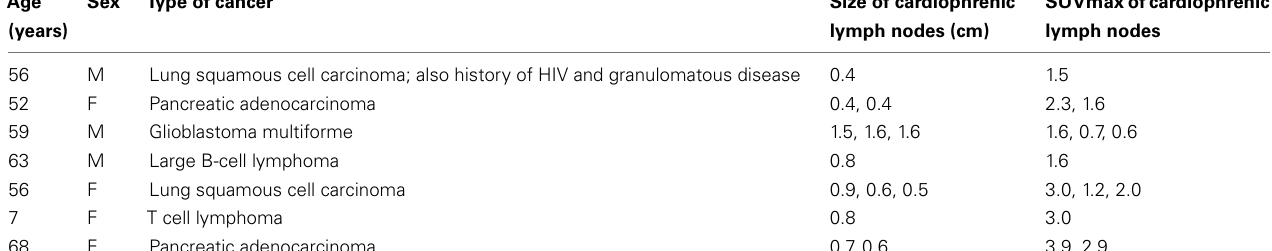
Table 1 | Summary of patient and lymph node characteristics.